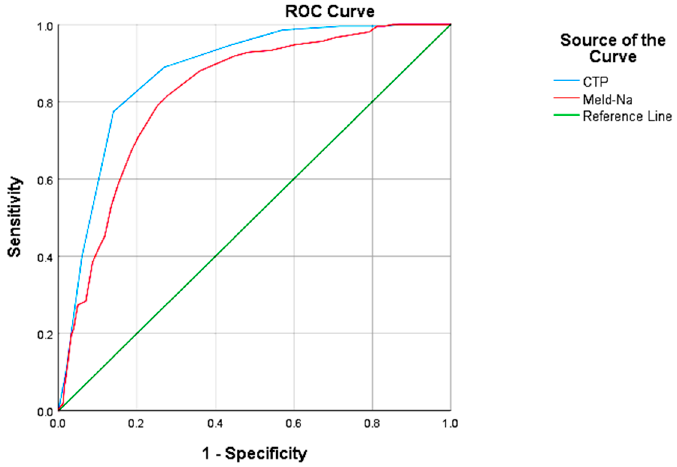
Figure 2. Analysis of the ROC curve for predicting scores (CTP and MELD-Na). CTP: Child–Turcotte–Pugh, MELD-Na: model for end-stage liver disease-sodium. Table 3. Performance of predicting scores (CTP and MELD-Na)—first hospitalization.